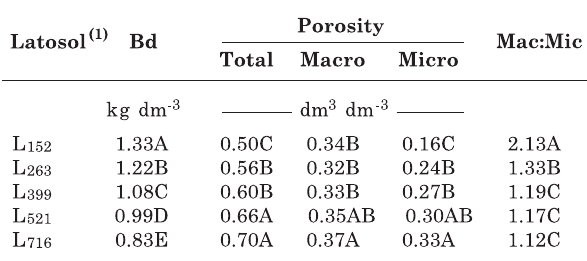
Table 3. Physical properties of Latosols (L) in the county of Rio Verde,